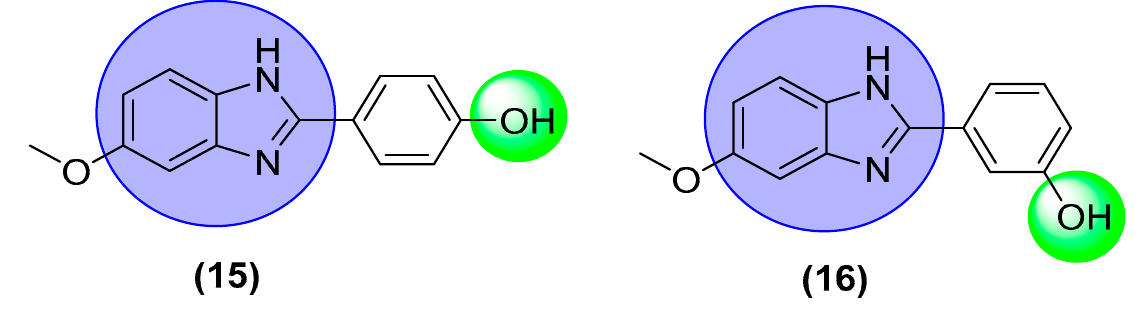
Figure 8. SAR studies of compounds 15 and 16 . Comparison of the nitro substituted compounds, 1 (IC 50 = 2.10 ± 0.10, 1.60 ± 0.10), 2 (IC 50 = 5.10 ± 0.10, 5.90 ± 0.10), and 4 (IC 50 = 3.40 ± 0.10, 3.60 ± 0.10) shows that analog 1 , in which the nitro group is at the para position, is superior in activity to analogs 2 and 4 , which have the nitro group at the ortho and meta positions. Thus, positional changes of the nitrogen atom causes a decline in the activity in the ortho and meta analogs (Figure